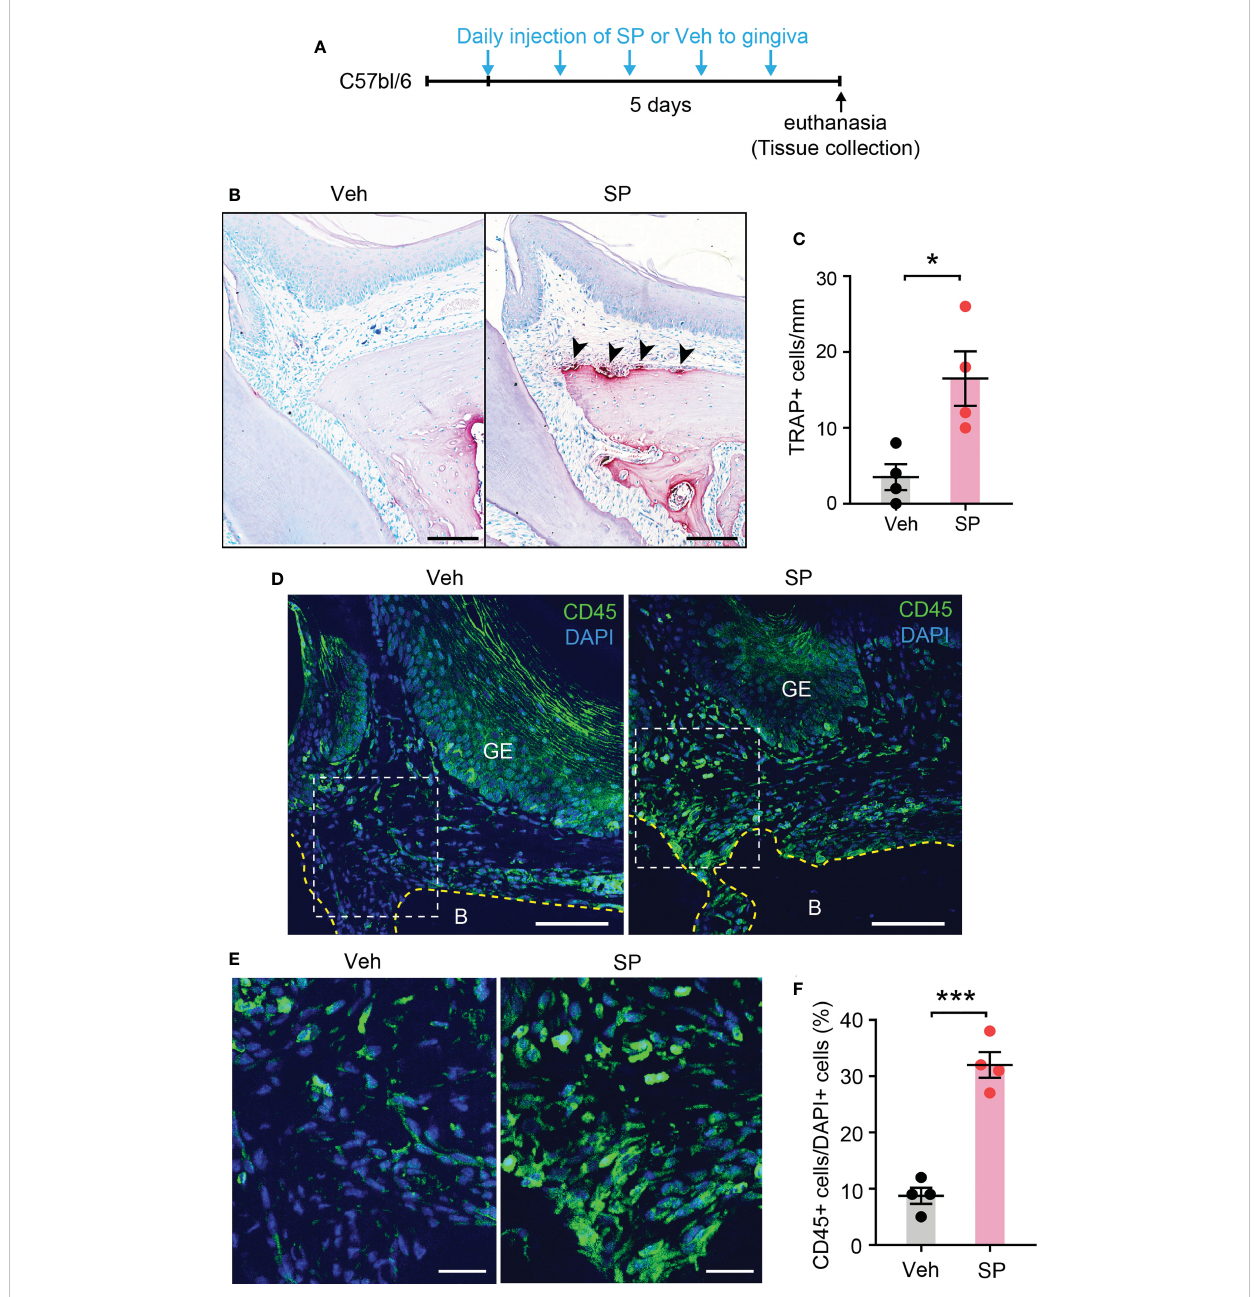
FIGURE 7 Exogenous injection of SP is suf fi cient to activate osteoclasts and to recruit immune cells in periodontium. (A) Time course of the experiment. (B) TRAP staining in substance P (SP; 1 µg/site)- or vehicle (Veh) injected into a periodontium. Scale bar, 100 µm. (C) Quanti fi cation of TRAP+ cells of the injected periodontia. *, p<0.05 in Student ’ s t-test. N=4 mice per group. (D) Immuno fl uorescence for CD45 in a periodontium injected with Veh or SP. Scale bar, 100µm. B, bone; GE, gingival epithelium. (E) Magni fi ed view of the insets in panel (D) Scale bar, 30µm. (F) Quanti fi cation of CD45+ cells. Percentage of the number of CD45+ cells among DAPI+ cells in gingival epithelium and connective tissues within 600 µm distance to tooth surface was calculated. ***p<0.0001 in Student ’ s t-test. N=4 mice per